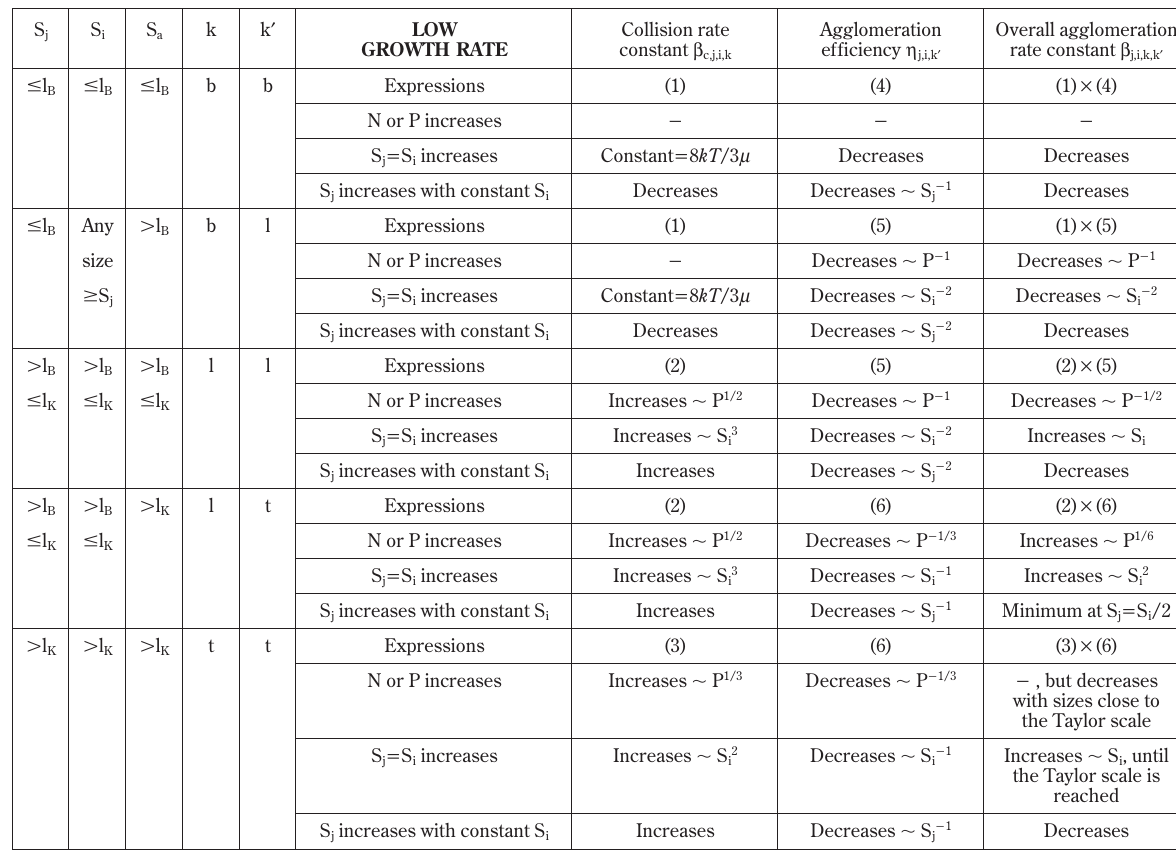
Table 2 Influence of stirring speed N or dissipated energy P, sizes of mother particles S j and S i on collision rate constant and efficiency for dif- ferent size ranges of mother particles and agglomerate. Case of low growth